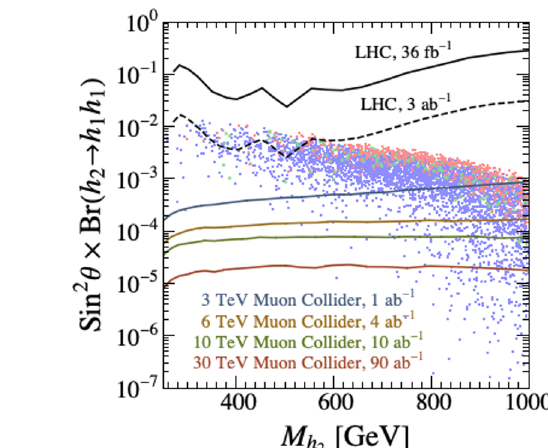
× Br ( h 2 → h 1 h 1 ) θ